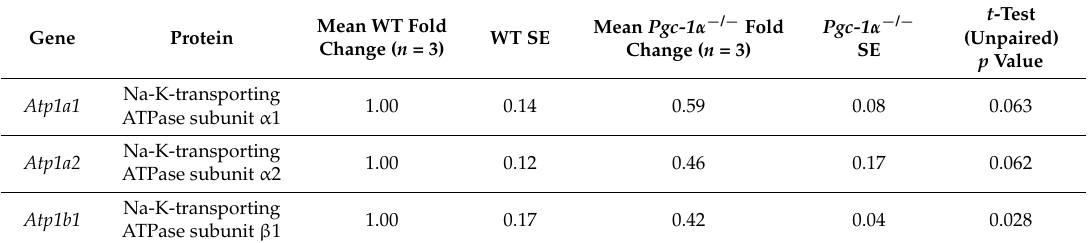
Table 1. The mean gene-fold changes underlying Na + -K + ATPase activity in Pgc-1 α − / − compared to WT